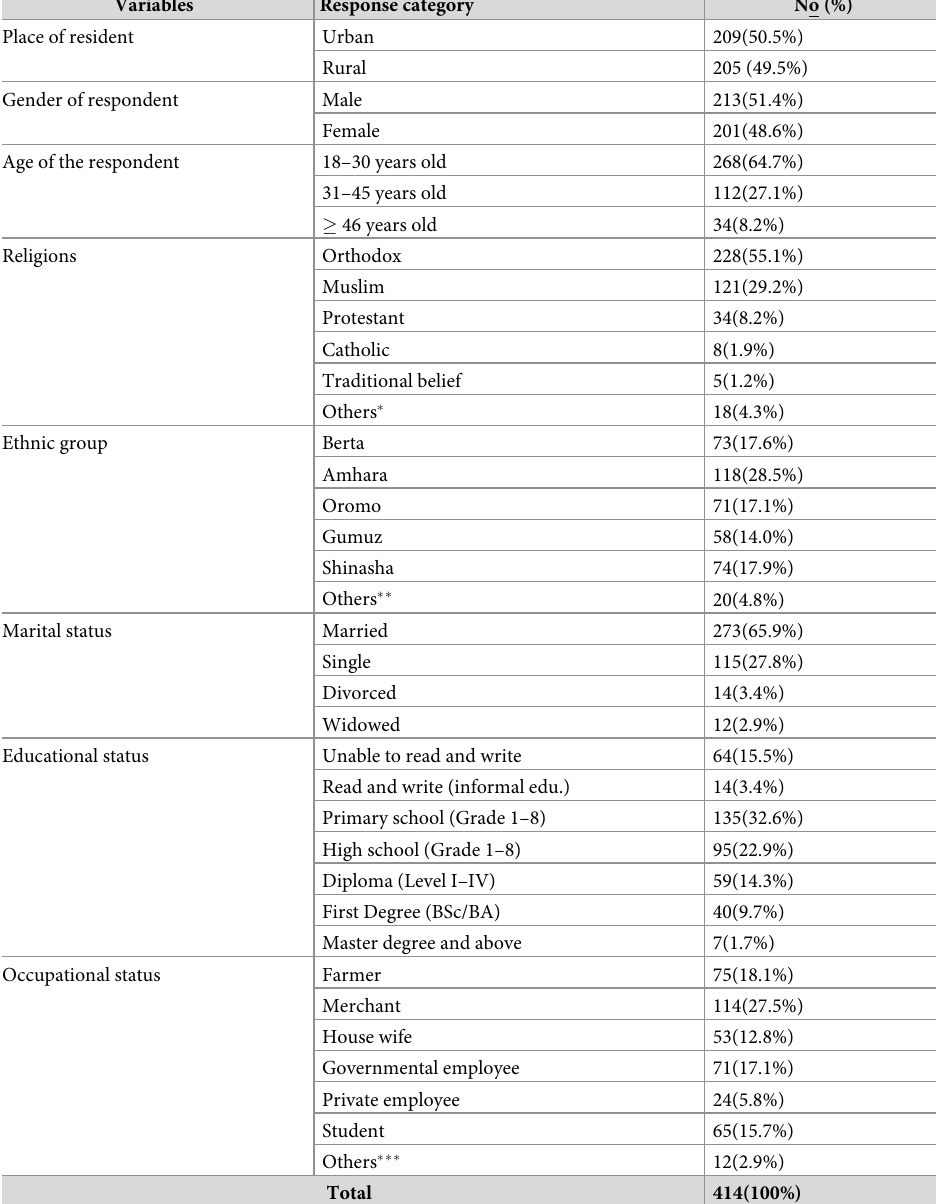
Table 1. Socio- demographic characteristic of the respondents in Benishangul Gumuz Region, Assosa, Ethiopia 2020.